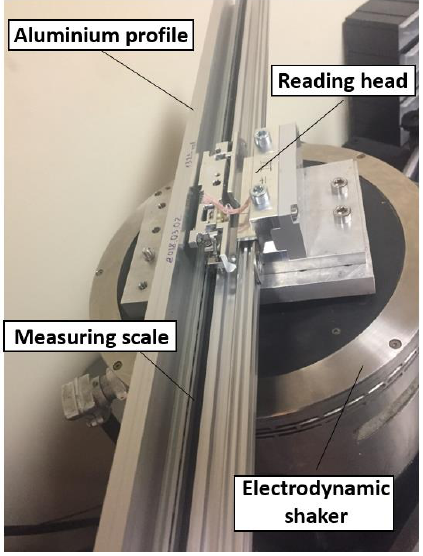
Figure 5. The experimental setup of the dynamic behavior